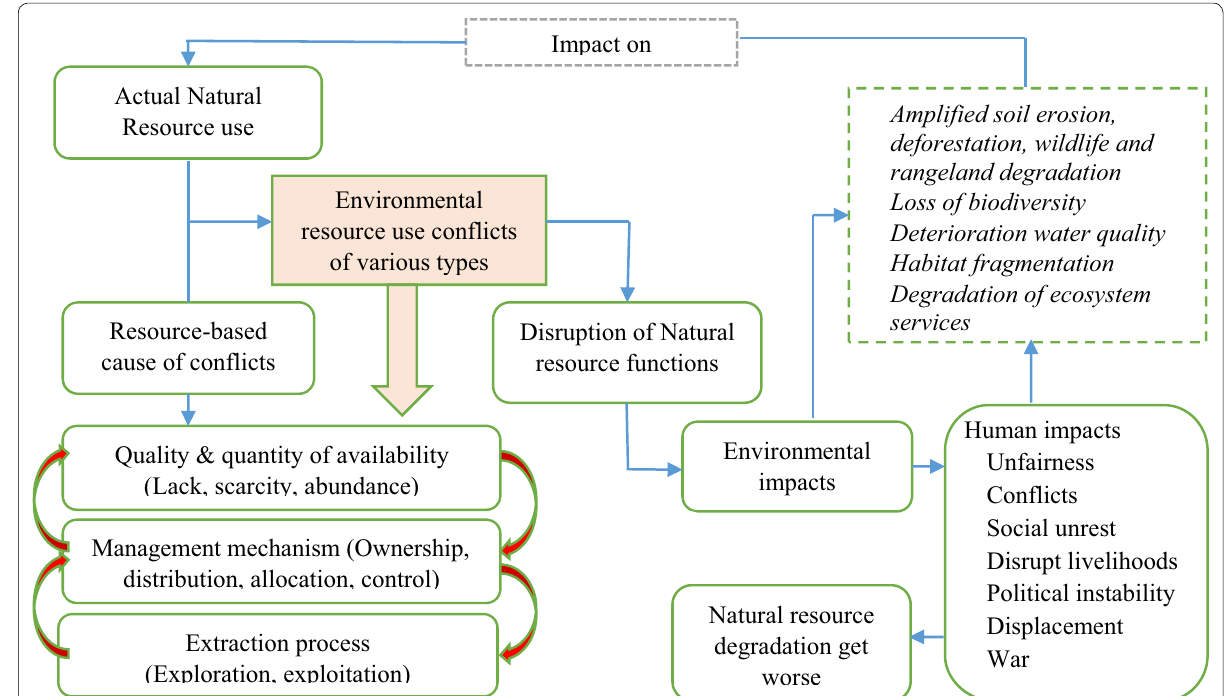
Fig. 4 Natural resource use conflicts and the related cascade of impacts. This figure illustrates how natural resource use in the environment triggers societal conflicts. The preliminary causes for such resource-based conflicts are quality and quantity of resource availability, extraction process of the available resources, and its management mechanisms. Defects in each will bring undesirable impacts on the environment and humans’ well-being; which in turn makes natural resource degradation worse. Source: Modified from Alao